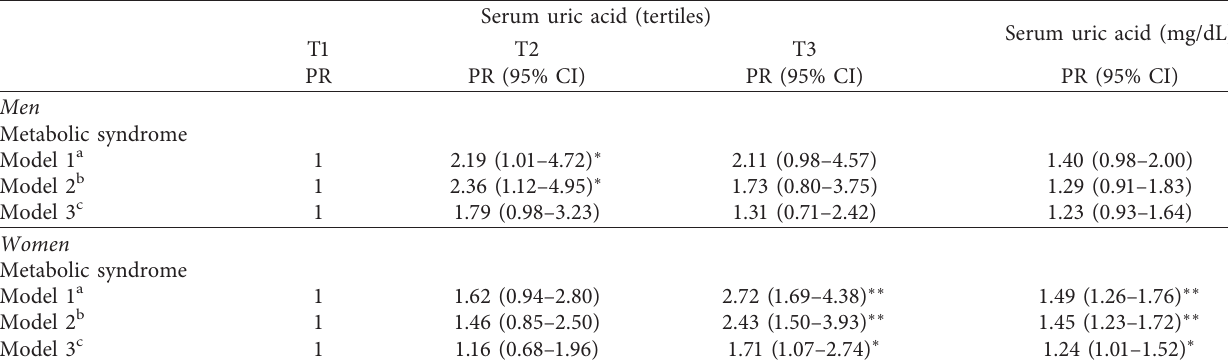
Figure 1: Components of metabolic syndrome frequency according to tertiles of uric acid. T1 (2.5–4.4mg/dL), T2 (4.5–5.0mg/dL), and T3 (5.1–6.3 mg/dL) in men; T1 (1.2–3.1mg/dL), T2 (3.2–3.8 mg/dL), and T3 (3.9–6.8mg/dL) in women. Table 1: Prevalence ratio for MetS according to SUA tertiles by overall population and sex.